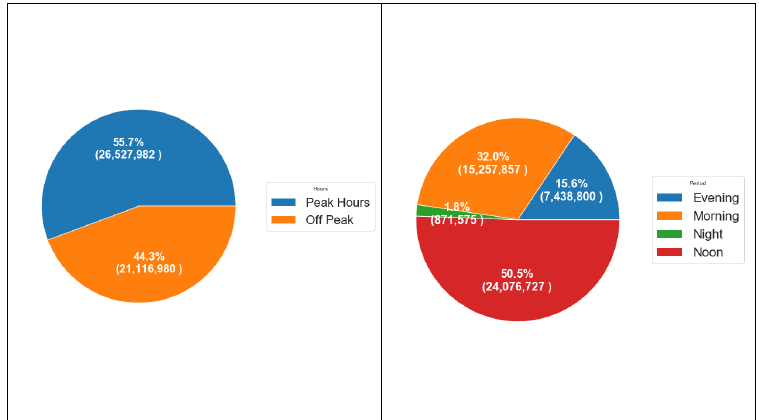
Figure 5. Electricity quantity charged in kWh per hour.